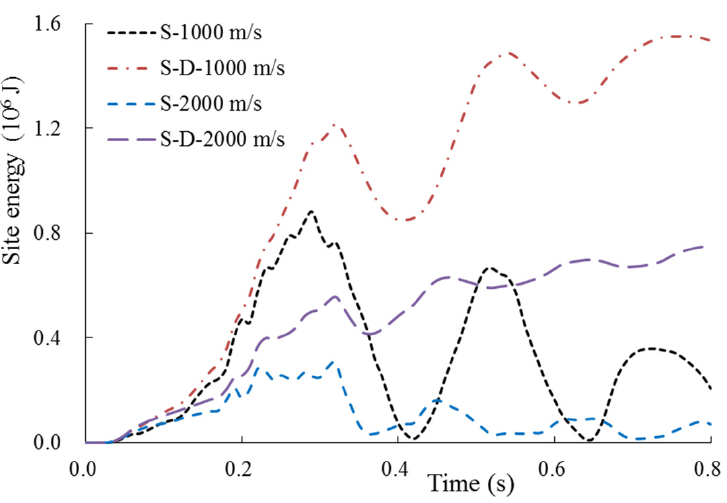
Figure 21. The spring-damper energy and spring energy for the sites of Vs = 1000 and 2000 m/s.